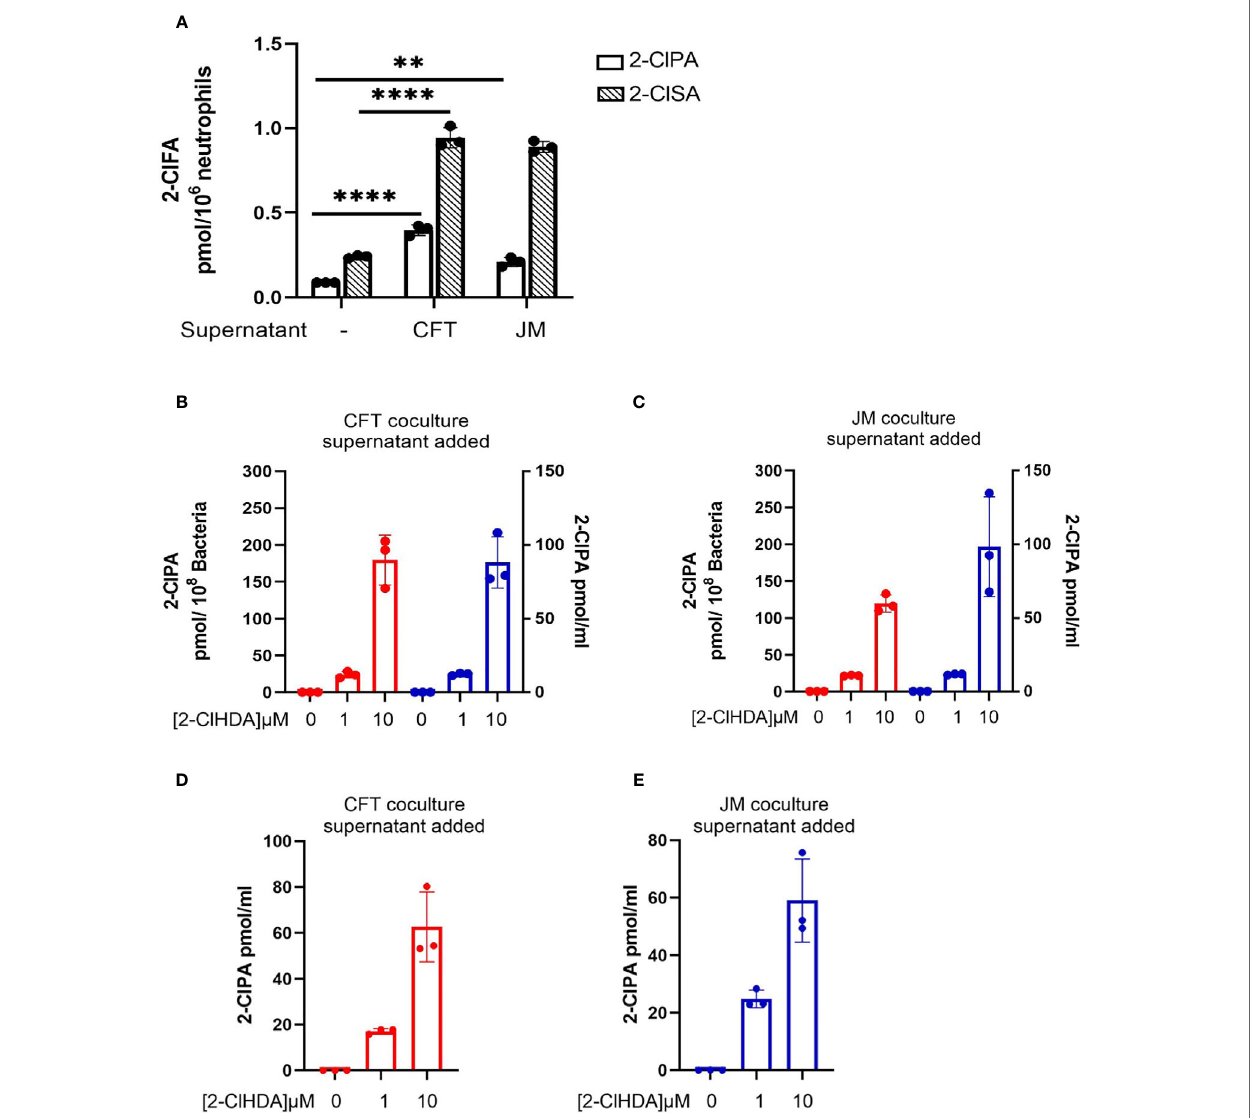
FIGURE 7 | Coculture supernatants amplify 2-ClFA production. 2x10 6 /ml neutrophils were cocultured with 20x10 6 /ml CFT073 or JM109 for 30 min at 37°C and the cells were pelleted. (A) The supernatants of CFT073 coculture or JM109 coculture were added to 1x10 6 /ml neutrophils for 1hr at 37°C and free 2-chloropalmitic acid (2-ClPA) and 2-chlorostearic acid (2-ClSA) were measured. (B, C) CFT073 coculture supernatant or JM109 coculture supernatant was added to 50x10 6 /ml of CFT073 (red) or JM109 (blue) and incubated with exogenous 2-chlorohexadecanal (2-ClHDA) for 1hr at 37°C and 2-ClPA was measured. (D, E) CFT073 or JM109 coculture supernatants were incubated with exogenous 2-ClHDA (0.1% EtOH) for 1 hour at 37°C without bacteria and 2-ClPA was measured. Each condition was performed with n=3 replicates.Statisticswere done usingone-wayANOVAwithTukey ’ smultiplecomparisontest.Error barsrepresents± SD, p-value: ****< 0.0001;**<